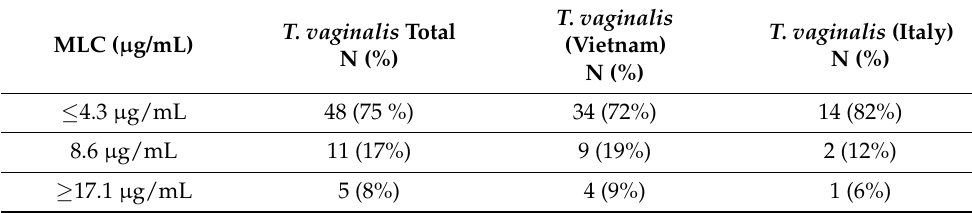
Table 2. The MLC value of metronidazole among T. vaginalis strains isolated from Vietnam and Italy. In vitro antimicrobial susceptibility of 64 T. vaginalis isolated strains was evaluated, and minimal lethal concentration was